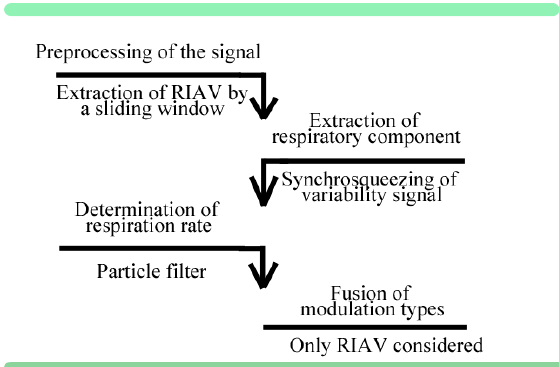
Figure 1. Operational phases of the generic respiration rate (RR) estimation algorithm (the text above the arrows). The methods used in the present study are shown below each arrow. The last step, fusion of different modulation types, is optional and was not implemented in this work since only respiratory-induced amplitude variation (RIAV) was studied.